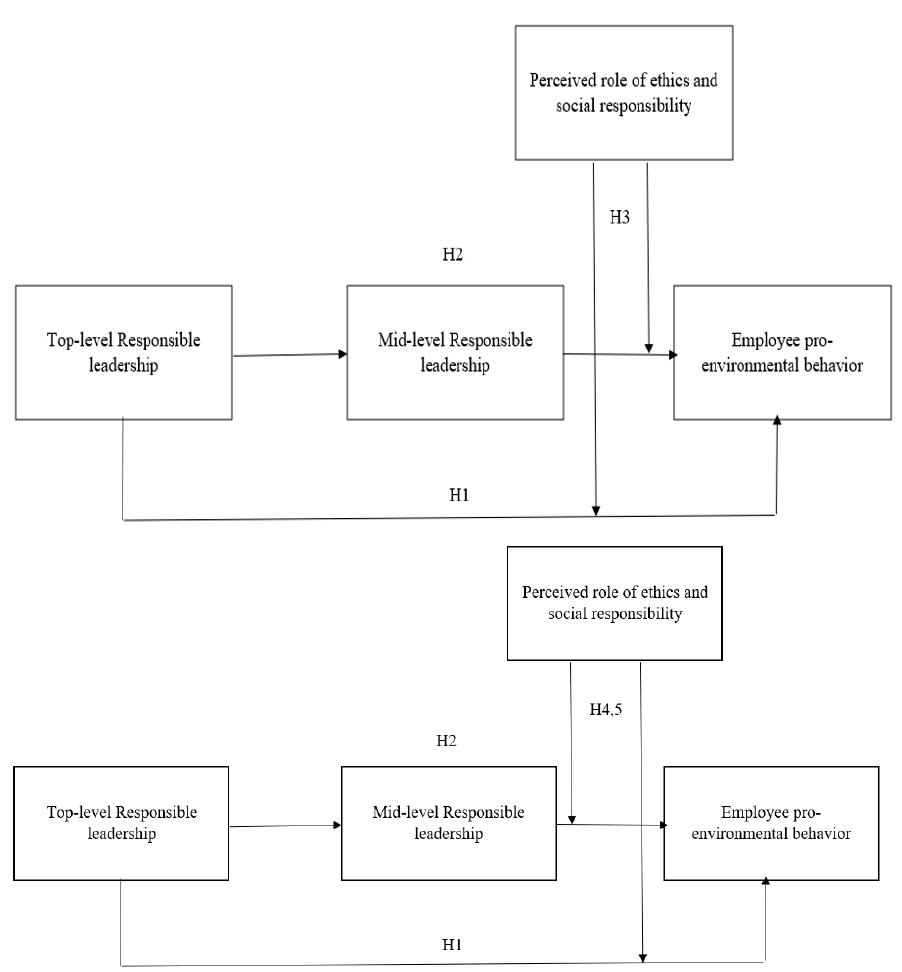
Figure 1. Theoretical model of the trickle-down effect of responsible leadership on employee pro-environmental behavior. H1: direct effect. H2: indirect effect. H4 and H5: contingent effects (moderated mediation).